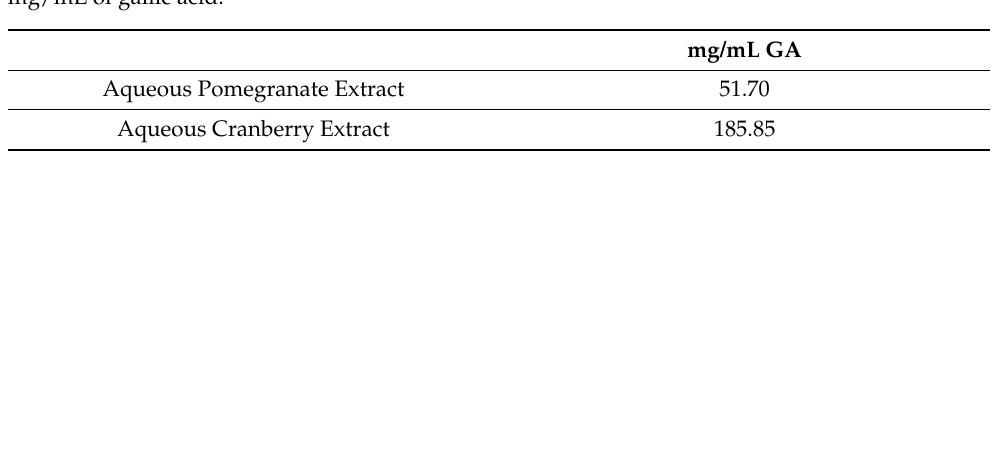
Table 2. Total phenolic content of the aqueous pomegranate and cranberry extracts expressed as mg/mL of gallic